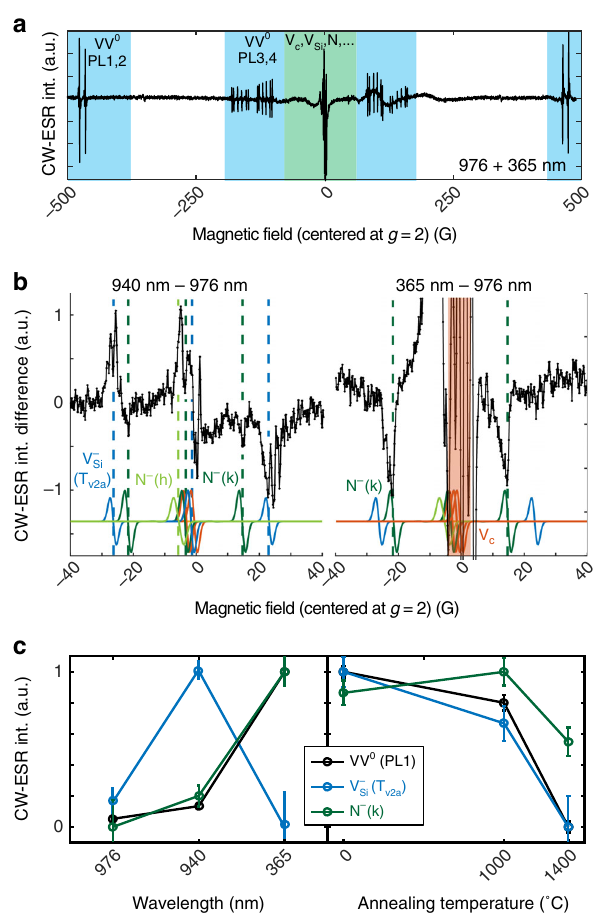
Fig. 4 ESR at 15 K in semi-insulating 4H-SiC under illumination. a CW-ESR spectrum measured at 9.7 GHz, and centered around g ≈ 2 ( ≈ 3470 G, aligned to the c axis). VV PL1 – 4 are highlighted in blue, while defects such as N, V C , or V Si are close to g ≈ 2 and highlighted in green. b Differential CW-ESR spectrum between either 940 nm and 976 nm excitation (left), or between 365 and 976 nm (right). Gaussian derivative lineshapes are simulated in color for known defects in 4H-SiC 18 . Their amplitudes only take into account transition probabilities, and not spin polarization or microwave saturation. c Normalized (per defect) CW-ESR intensity under 976, 940, and 365 nm (left) and for different annealing condition of the sample (right). For VV 0 , 365 nm is combined with 976 nm for spin polarization (and obtain enough signal). For the annealing dependence, the intensity was fi tted under the best illumination condition for each defect, that is the maximum signal in the left. Annealed samples were only used in this panel ( c , right). Error bars are 95% con fi dence intervals from the fi t